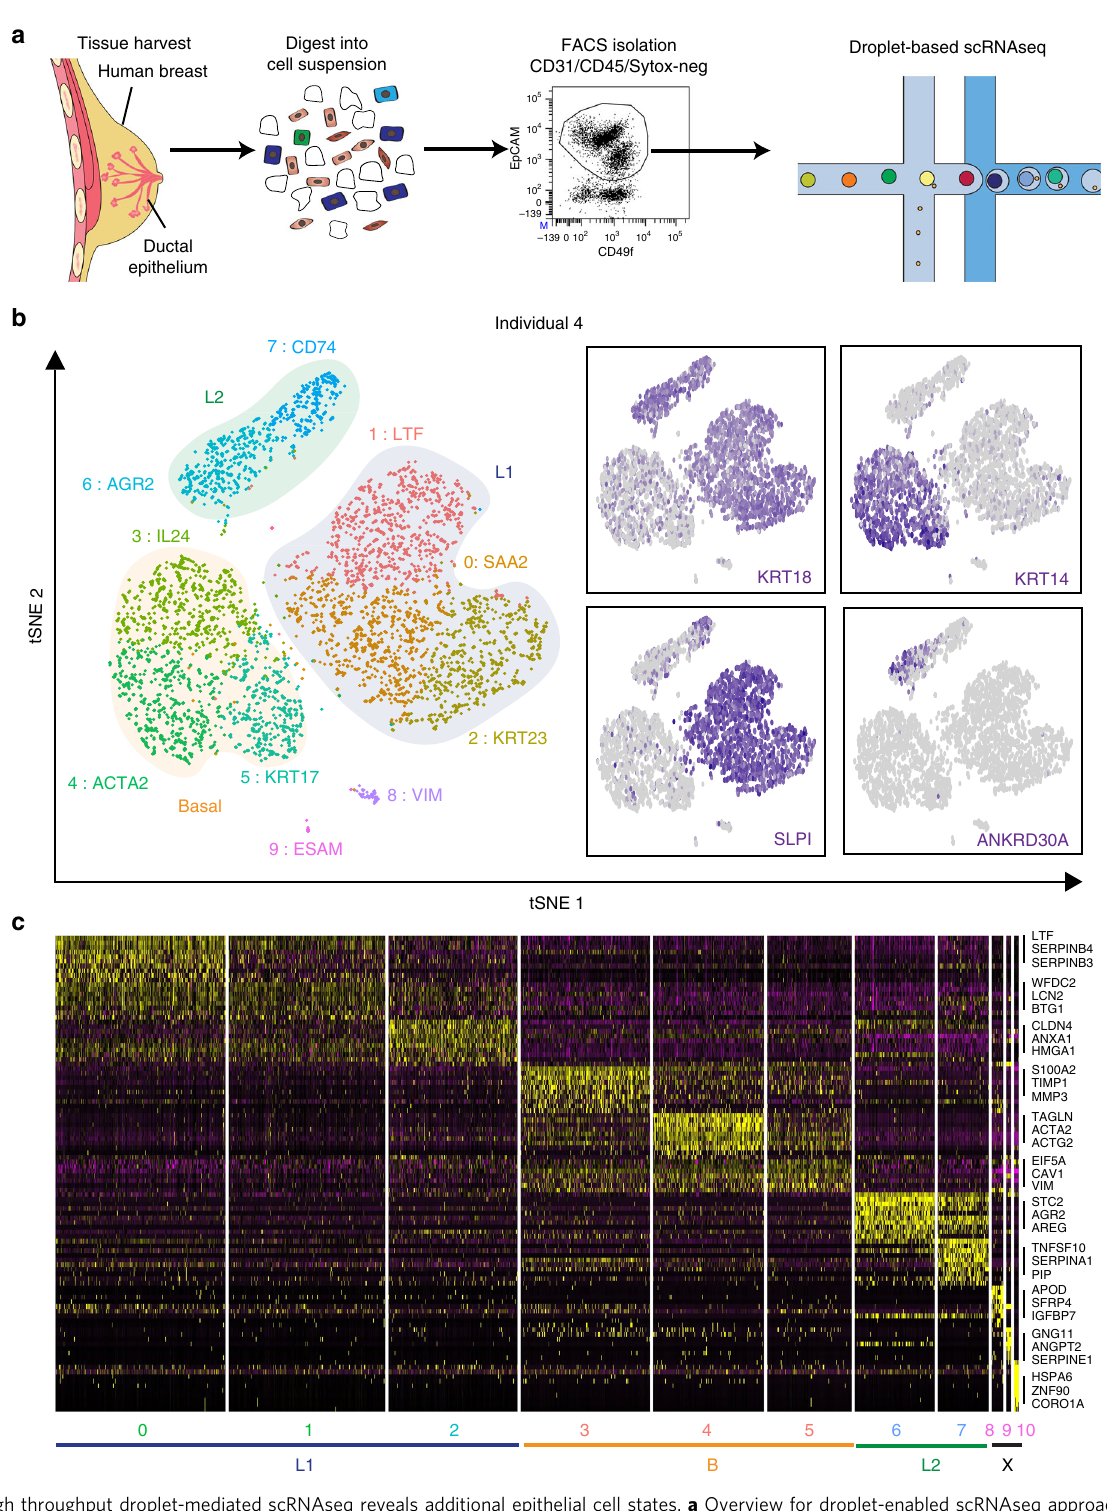
Fig. 2 High throughput droplet-mediated scRNAseq reveals additional epithelial cell states. a Overview for droplet-enabled scRNAseq approach as described above; basal and luminal epithelial cells were sorted together and subjected to combined scRNAseq analysis using the droplet-based scRNAseq. b Data from individual four was analyzed using Seurat and the distinct clusters (0 – 10) are displayed in tSNE projection with selected marker gene for each cluster, and main epithelial cell types (Basal, L1, L2) are outlined. Feature plots of characteristic markers for the three main cell types are shown on the right showing expression levels as gradient of purple. c Heatmap showing the top ten marker genes for each cluster as determined by Seurat analysis with three selected genes per cluster highlighted on the right. See Supplementary Fig. 2 for individual clustering and marker gene analyses for Individuals 5 –